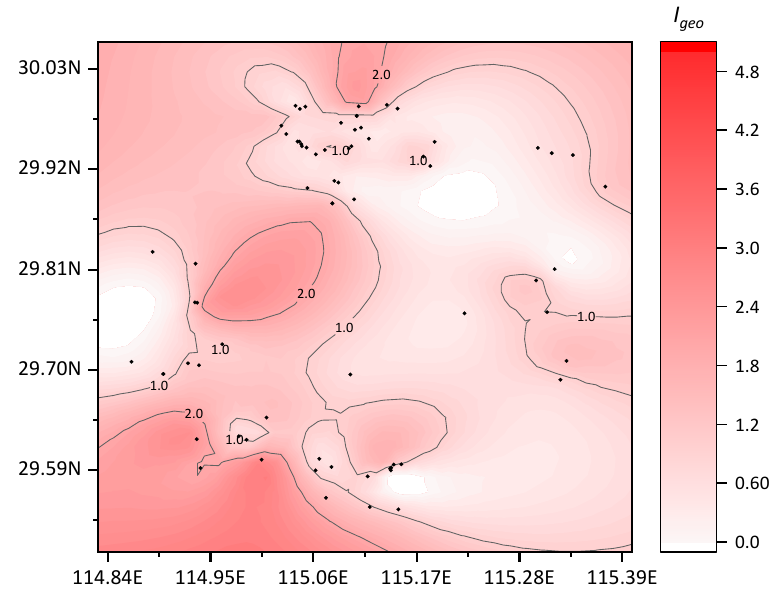
Figure 4. Distribution map of the geo-accumulation index ( I geo ).